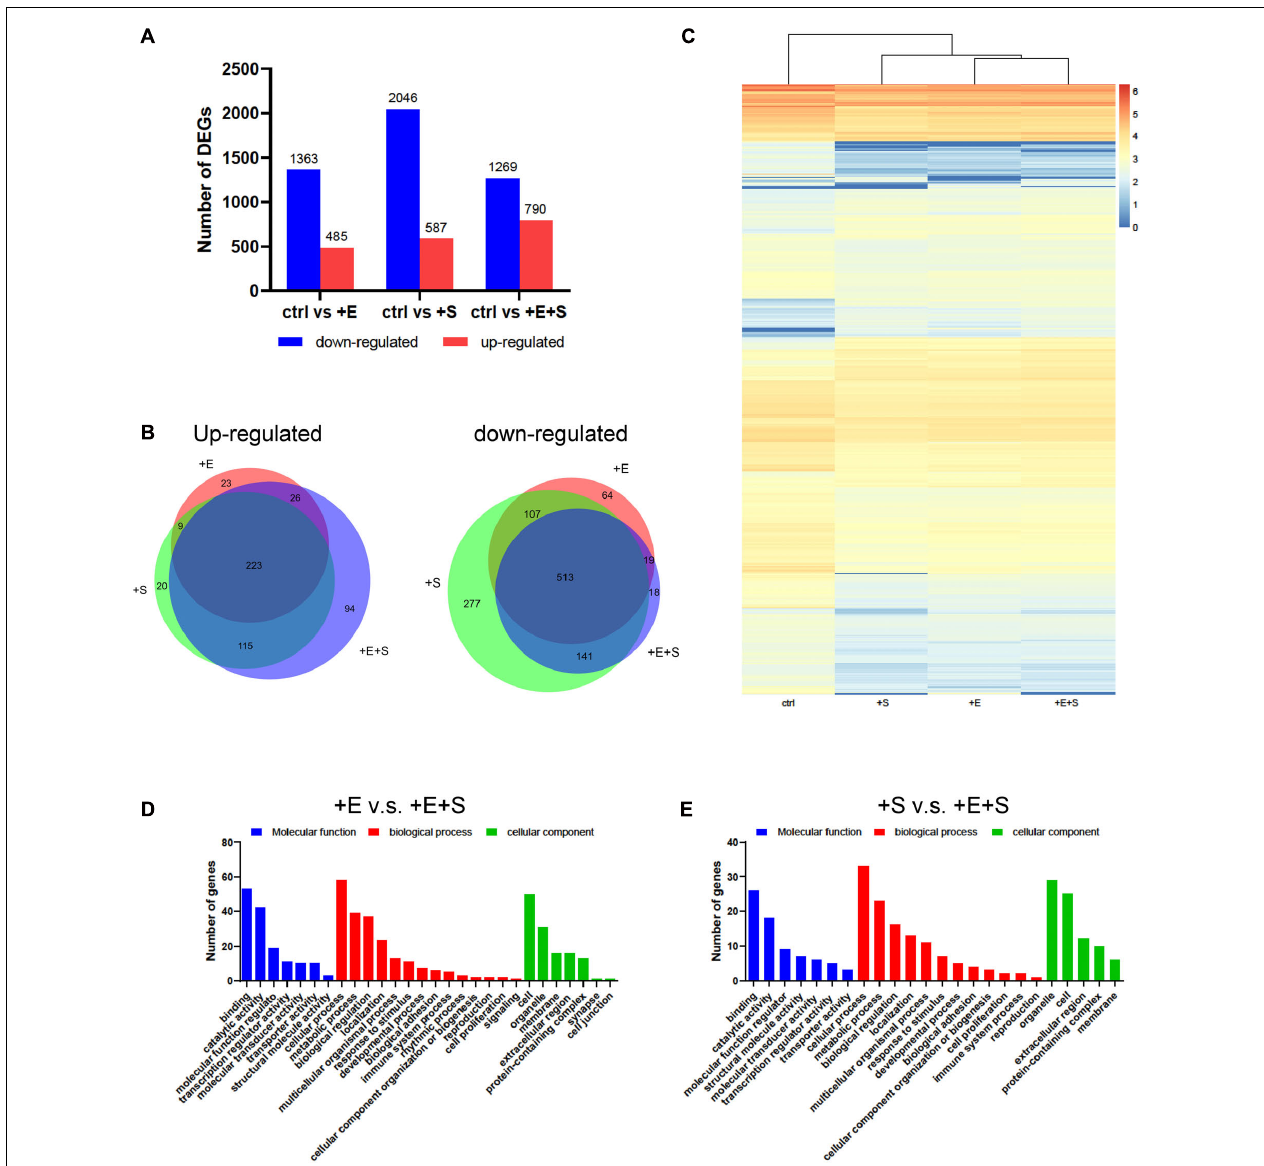
FIGURE 6 | Changes in gene expression profiles of neural differentiated BMSCs under different stimulations. (A) Numbers of DEGs compared with only EGF and FGF2 induction with EF and/or stain treatments. (B) Venn diagram showed the overlap genes among different treatments. (C) Heat map diagrams showed the relative expression levels of total DEGs under different stimulations. (D) DEGs between EF and co-stimulation. (E) DEGs between strain and